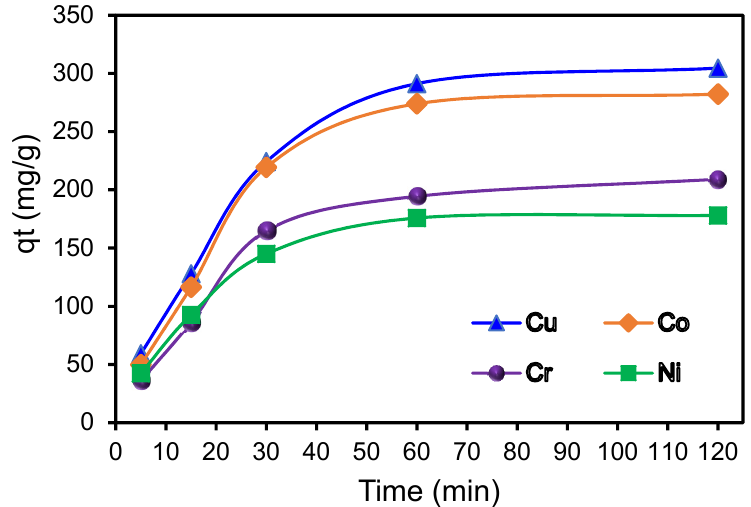
Figure 9. The effect of different binding contact time of selected metal ions by poly(hydroxamic acid); experimental conditions: 100 mg of dried poly(hydroxamic acid), 10 mL of 0.1 M CH 3 COONa buffer solution at pH 6, and 5 mL of 0.1 M heavy metal solutions agitated for 5, 15, 30, 60, and 120 min.